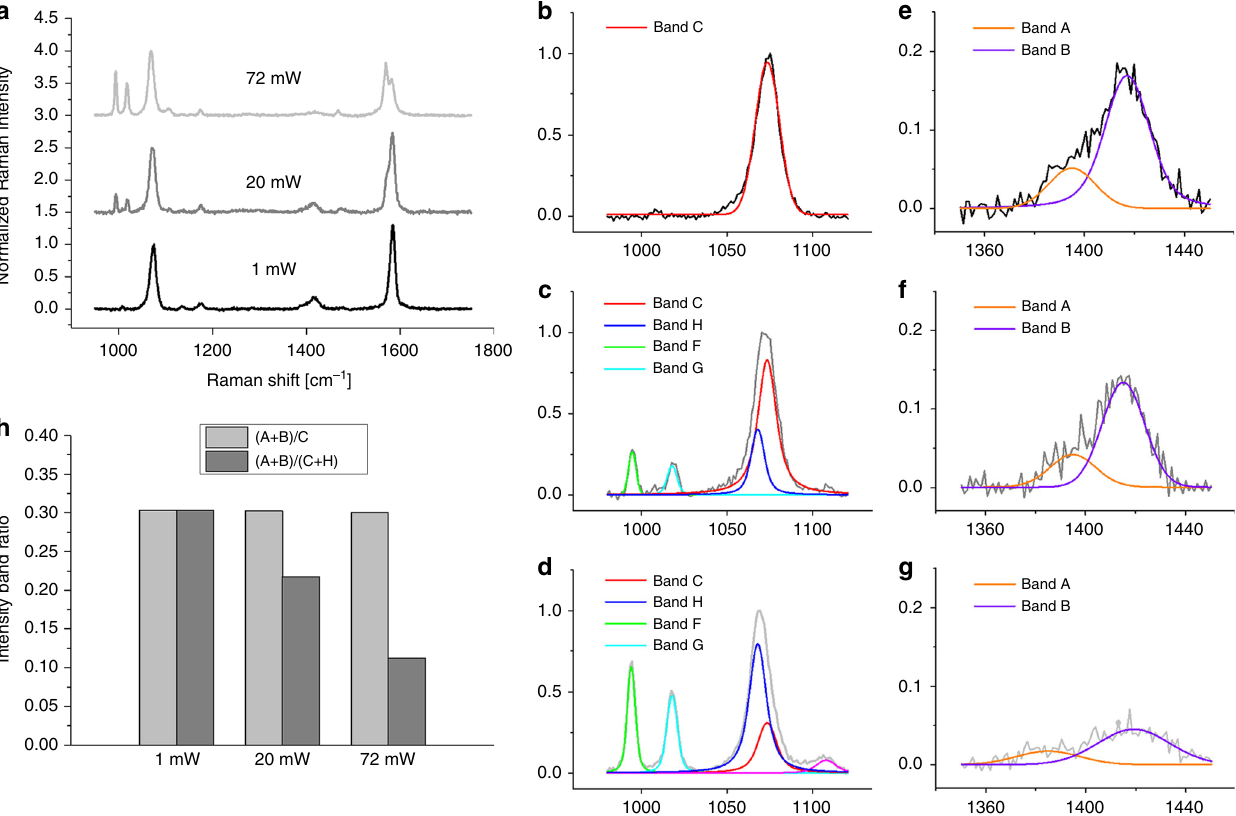
Fig. 6 Modi fi cation of the 4-MBA SAM during SERS analysis. a Typical 4-MBA spectra obtained from the same AuNP colloidal solution (pH = 7.4) at 1, 20, and 72 mW, normalized to the intensity detected at around 1068 cm − 1 . b – d Experimental intensities and band fi tting in the range 980 – 1120 cm − 1 from the spectra in a acquired at 1, 20, and 74 mW, respectively. In e – g , intensities and band fi tting results are shown in the range 1350 – 1450 cm − 1 as acquired at 1, 20, and 74 mW, respectively. h Comparison of the intensity band ratios (A + B)/C and (A + B)/(C + H) calculated at different outputs of the laser source, from the spectra shown in